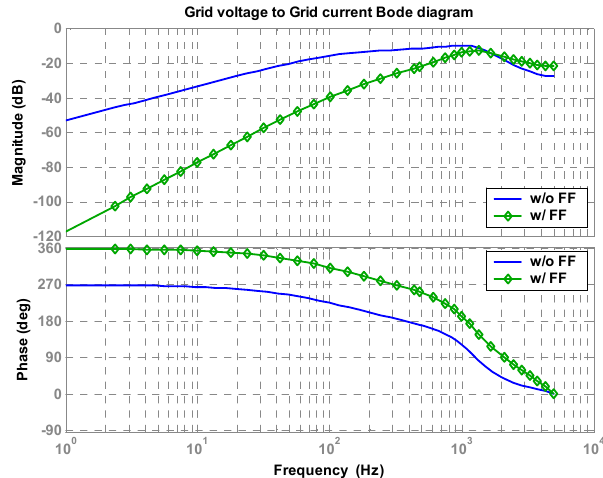
Figure 10. Grid-voltage disturbance effects with and without the duty-ratio feed forward on the condition of the output voltage of the PV is 120 V and output power is 1 kW.